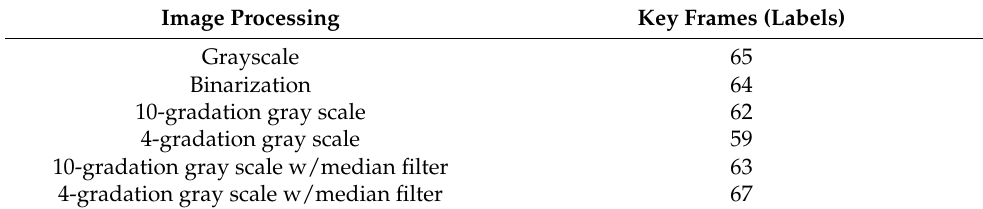
Table 8. Key frames (labels) per processing strategy.